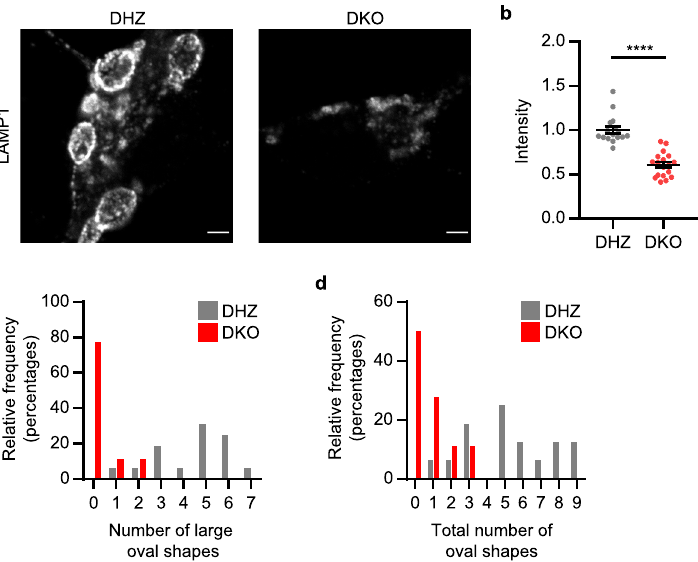
Figure 4. LAMP1 staining intensity and shape are abnormal in Vti1a/b deficient neurons. ( a ) Representative examples of neurons immunostained for LAMP1. ( b ) Normalized staining intensity of LAMP1 is decreased in Vti1a/b DKO neurons compared to DHZ neurons (DHZ: n = 16; DKO: n = 18). Mann Whitney test: ****p < 0.0001. ( c ) Number of large, clear oval LAMP1 shapes is decreased in Vti1a/b deficient neurons (DHZ: n = 16; DKO: n = 18). Mann Whitney test: ****p < 0.0001. ( d ) Total number of oval LAMP1 shapes (including less distinguished ovals) is decreased in Vti1a/b deficient neurons (DHZ: n = 16; DKO: n = 18). Mann Whitney test: ****p < 0.0001. Bars show mean ± SEM. Detailed statistics are shown in Supplementary Table 1. Scale bar is 2